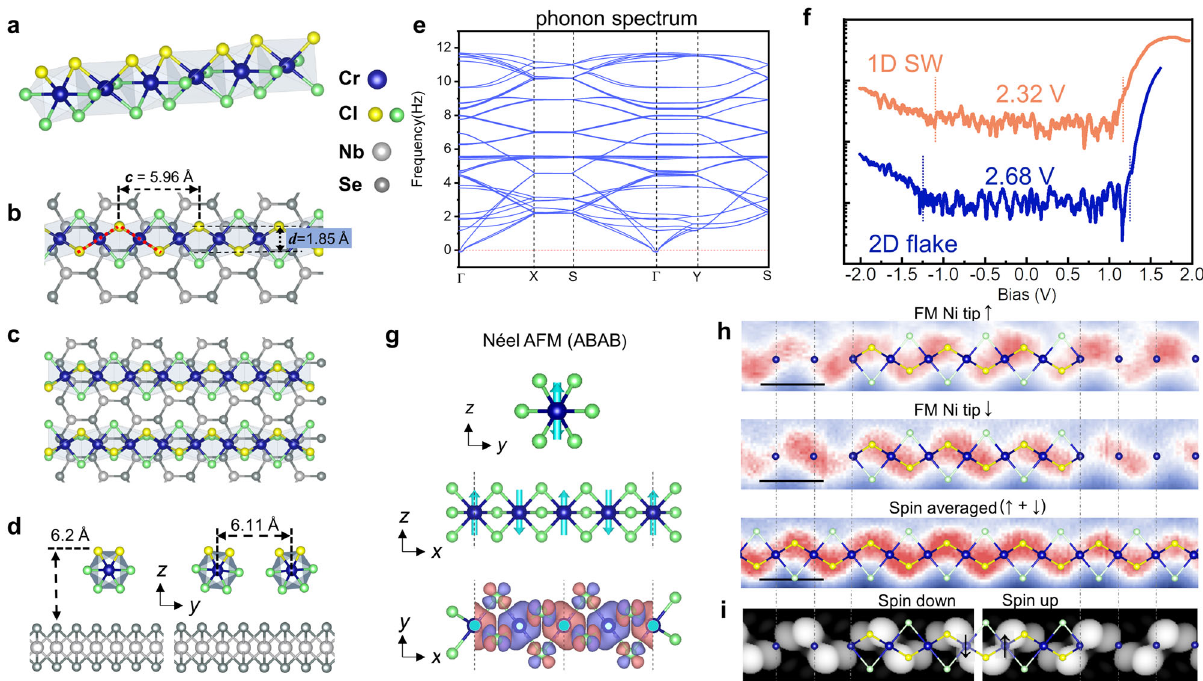
Fig. 2 | Atomic, electronic, and magnetic structures of 1D CrCl3 wires. a PerspectiveviewofasingleCrCl 3 wirecomposedofface-sharingCrCl 6 octahedra (shadowed). b , c Topviewsofthemoststablecon fi gurationsof thesinglewireand bi-wires on the adsorbed NbSe 2 obtained in our DFT calculations. The corre- spondingcross-sectionalviewsareshownin( d ).TheCratomsaredisplayedinblue, and the Cl atoms are displayed in yellow (for the topmost ones) and green. e Calculated phonon spectrum of the CrCl 3 wire array with an in fi nite width. f Typical d I /d V spectra (on a logarithmic scale) of a single wire (orange) and a 2D CrCl 3 fl ake (blue). The band gap values are labeled. g Schematics of the spin con- fi guration in a single wire. A total energy comparison among various magnetic